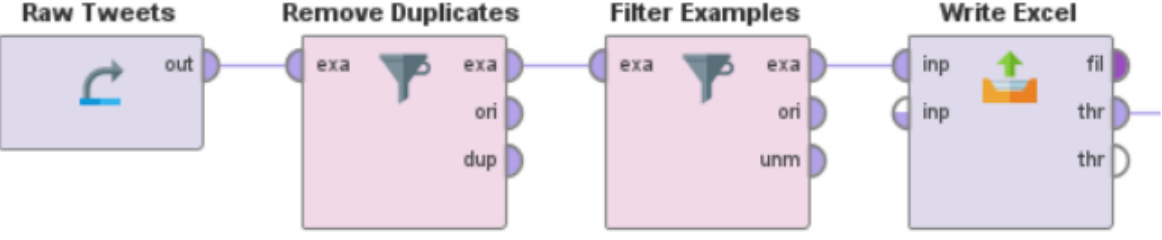
Figure 2. Process Flow in RapidMiner from raw tweets of which duplicates were removed and filtered before writing an Excel File.